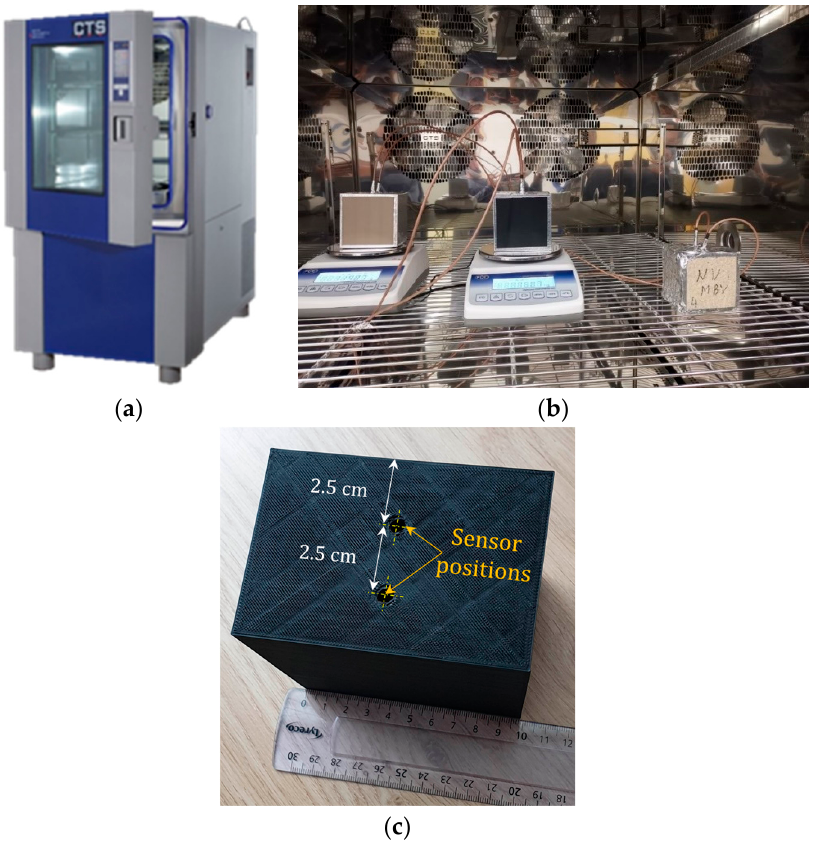
Figure 2. Hygrothermal behaviour analysis using climatic chamber: ( a ) Overview of the climatic chamber, ( b ) samples inside the climatic chamber (PF-10% infill on the left, PLA-10% infill in the middle, and hemp concrete on the right), and ( c ) a zoomed view on a sample printed using an infill of 10% and a printing temperature of 200 °C with sensor positions.